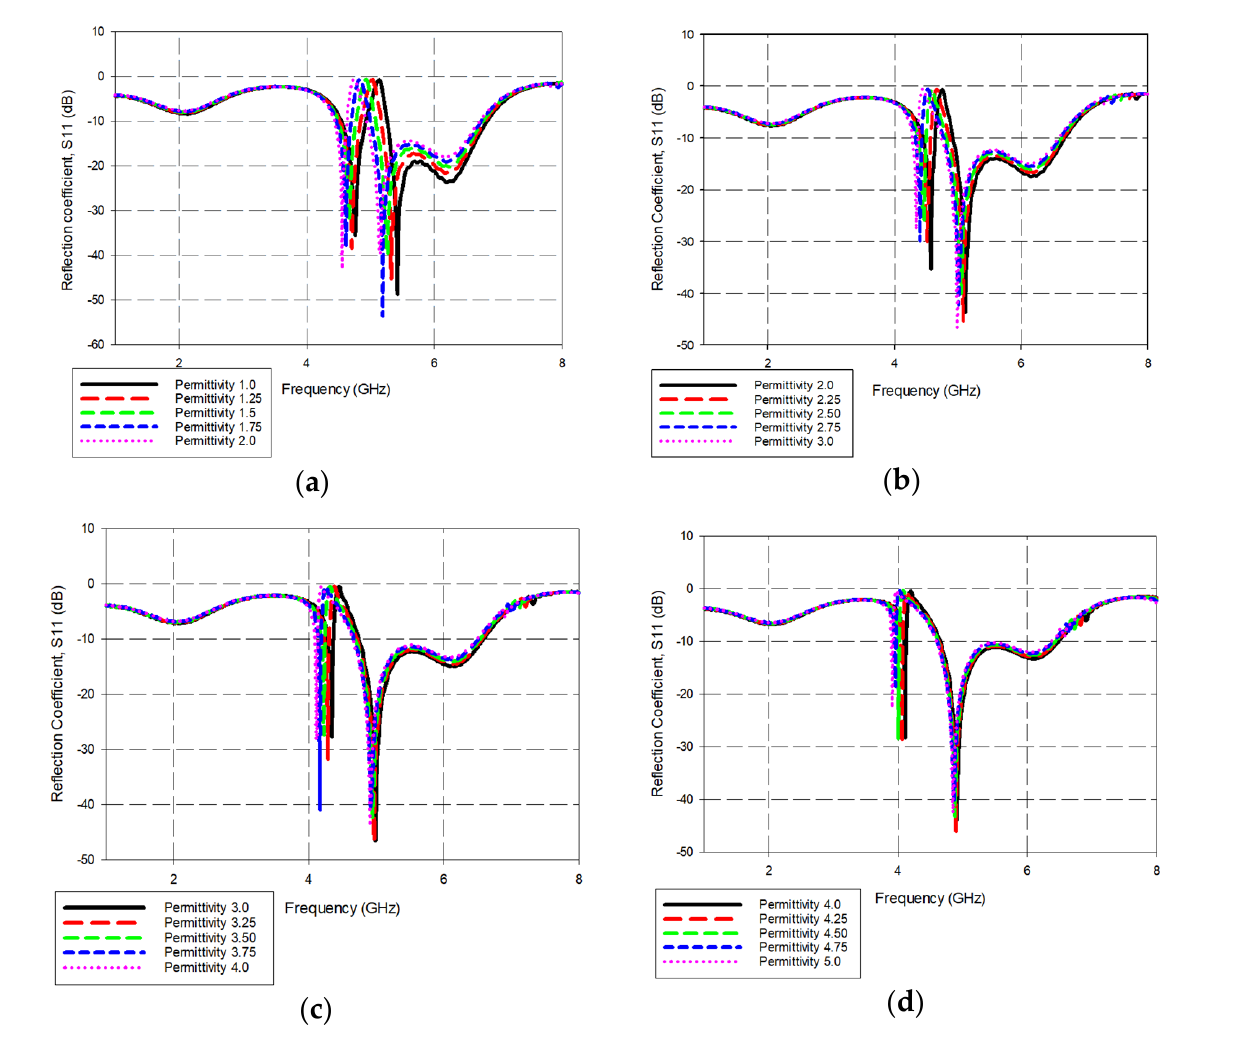
12 of 23 Figure 14. Proposed sensor with MUT on the top. 3. The Resonant Frequency Analysis The designed resonator structure underwent several frequency-permi tt ivity analyses in order to verify its performance with the potential physical MUTs that were to be intro- duced to the structure. A set of dielectric constants ranging from 1–5 was simulated to evaluate shifts in the resonance frequency, fr as depicted in Figure 15. The simulation trend showed a shift to the left when a larger permi tt ivity was introduced. The peak res- onance frequency did not seem to change, but the overall response decreased when a larger permi tt ivity was introduced. ( a ) ( b ) Figure 15. Shifting in resonance of ( a ) re fl ection coe ffi cient (S11) and ( b ) transmission coe ffi cient when simulated with a range of 1 − 5 dielectric constant.